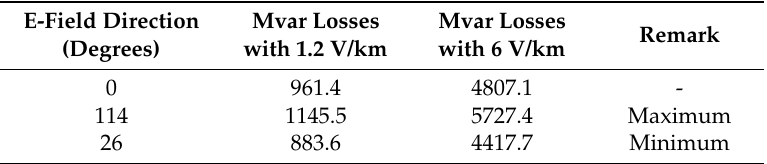
Table 4. Additional Mvar losses at transformers with 1.2 V/km geomagnetic disturbances (GMD) in a Korean power system.